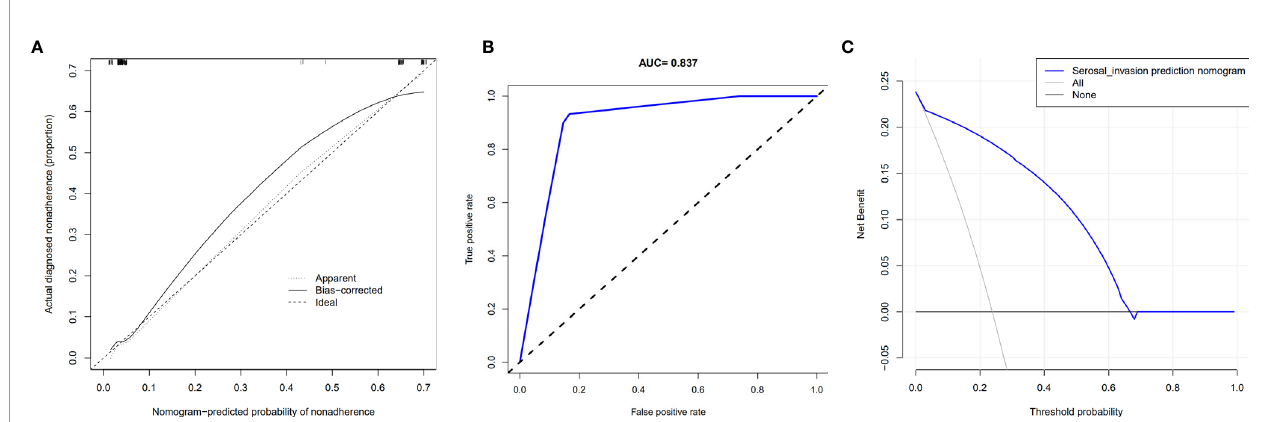
FIGURE 4 | Calibration curve of the radiomics nomogram, area under the curve of the prediction model, and decision curve analysis for the radiomics nomogram in the testing cohort. (A) The calibration curve depicts the consistency between the predicted values of serosal invasion and the actual observed values. (B) The area under the curve represents the reliability of the model. (C) The blue line represents the bene fi t of the patient after using the prediction model.